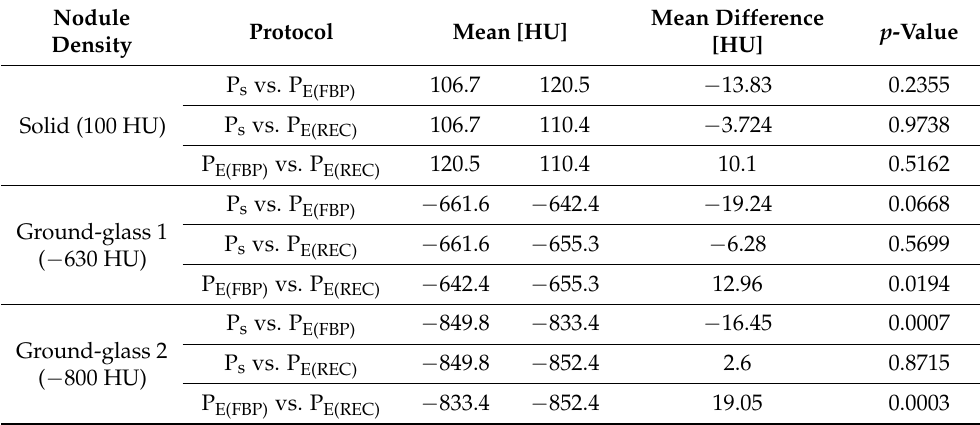
Table 4. Differences in observed attenuation amidst different scan protocols. The table above exhibits and compares the difference of measured CT attenuation (HU, Hounsfield Units) among the selected scan protocols. Institute-specific standard low-dose protocols (P S ) and ESTI protocols (P E ) reconstructed with filtered back projection (P E(FBP) ) as well as with iterative reconstruction (P E(REC) ) were